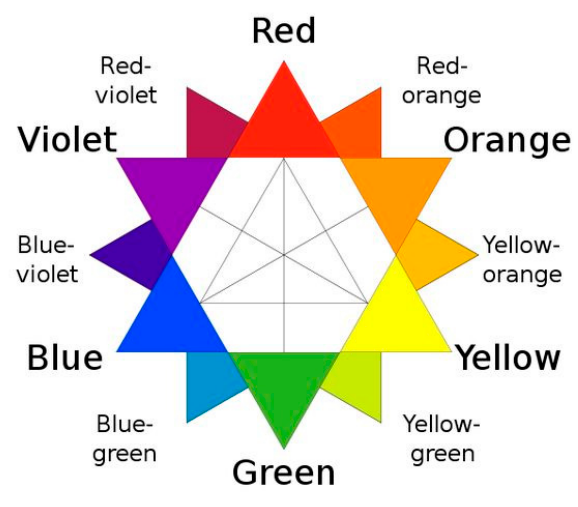
Figure 1. 12 RYB color wheel. These images are used under GNU Free Documentation License.